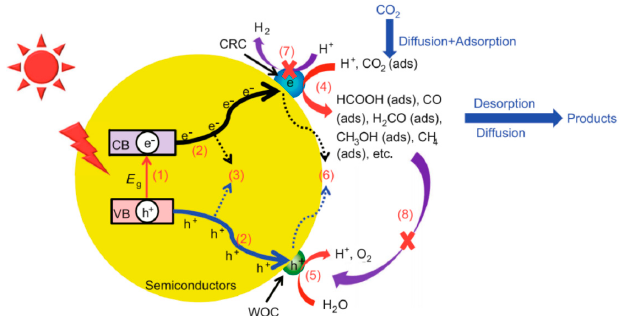
Figure 8. Processes involved in photocatalytic CO 2 reduction over a heterogeneous photocatalyst. CRC, CO 2 reduction co-catalysts; WOC, water oxidation co-catalysts [90].